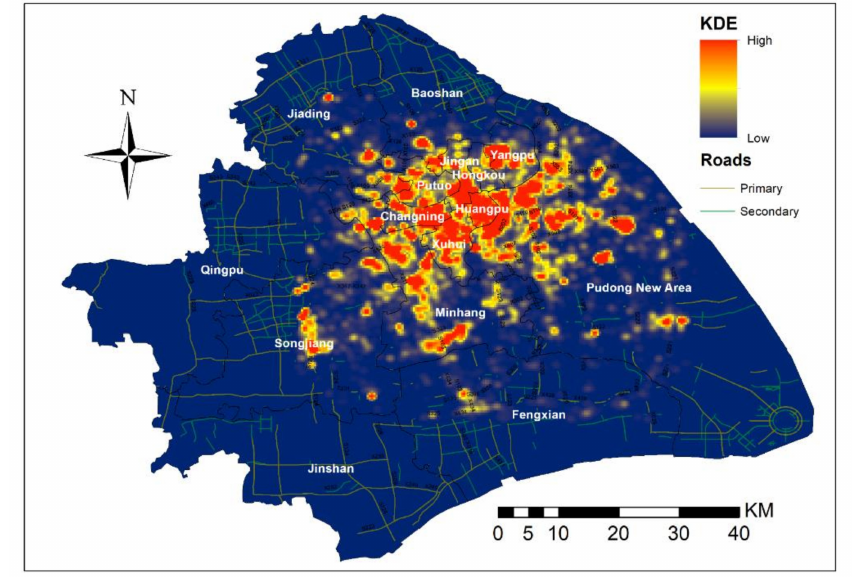
Figure 6. Overall Density of